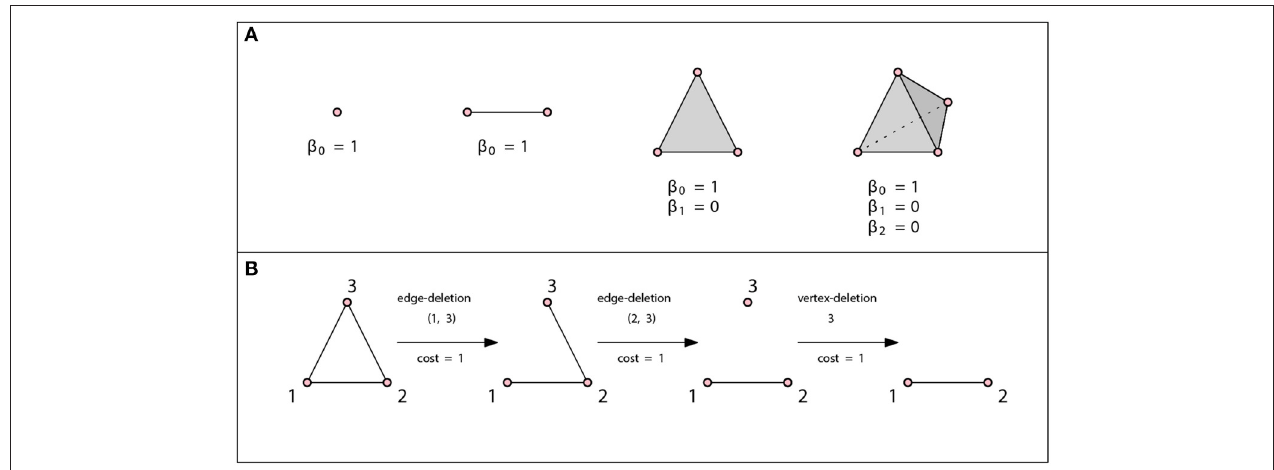
FIGURE 2 | (A) A vertex, an edge, a triangle, and a tetrahedron. In all three cases β 0 = 1. There are no loops or higher dimensional voids and therefore β n = 0 for n ≥ 1 . (B) Example of an edit path whose cost is 3. This is the minimal cost edit path, thus the graph edit distance between these two graphs is 3.